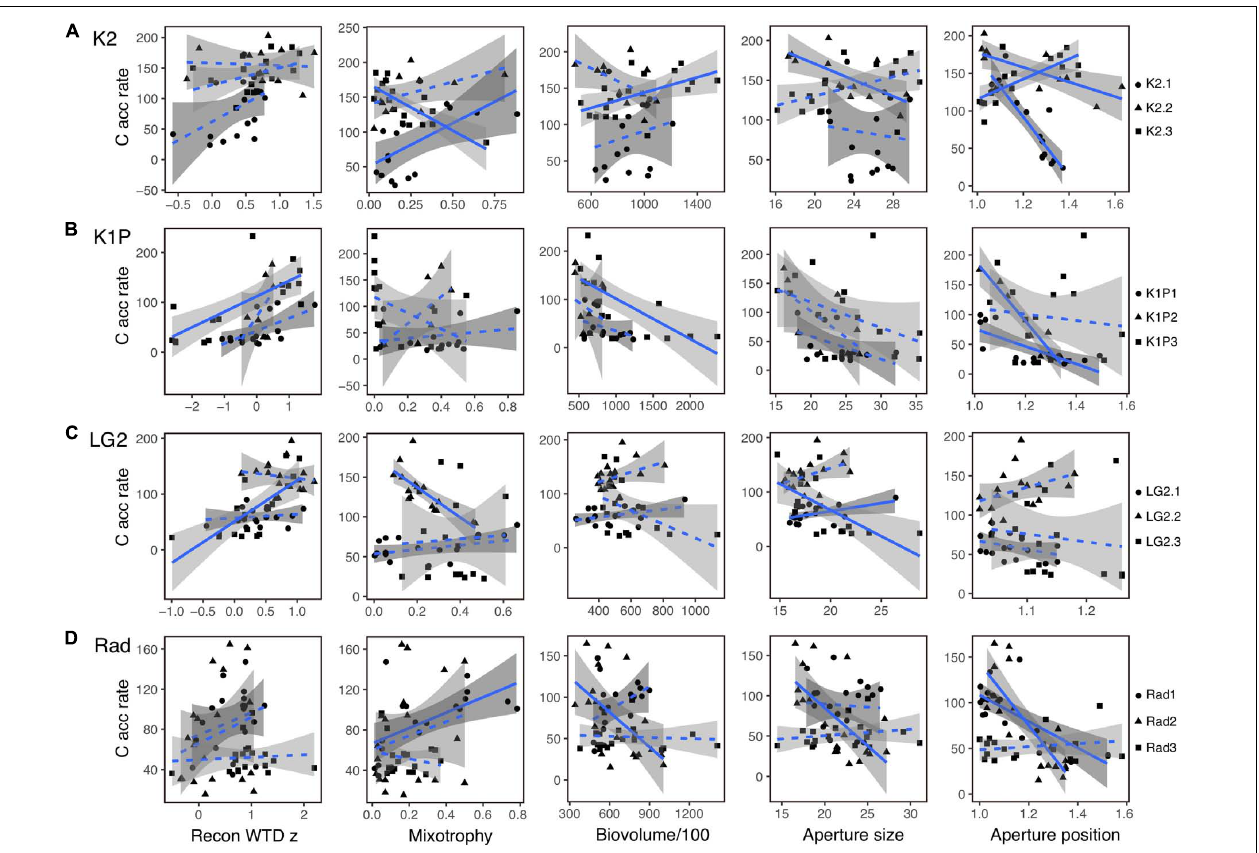
FIGURE 6 | Linear regression analysis of carbon accumulation rate (C acc rate; g C m − 2 y − 1 ) and reconstructed water-table depth z score (Rec WTD z ), mixotrophy, biovolume/100 ( µ m 3 ), aperture size ( µ m) and aperture position for each peat record at sites K2 (A) , K1P (B) , LG2 (C) and Rad (D) . The gray shading areas represent the 95% confidence intervals. Correlations with p < 0.05 were indicated using solid lines and correlations with p > 0.05 using dashed